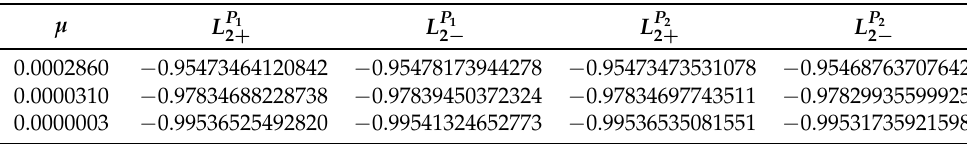
Table 5. Equilibrium solution near L 2 of different planetary